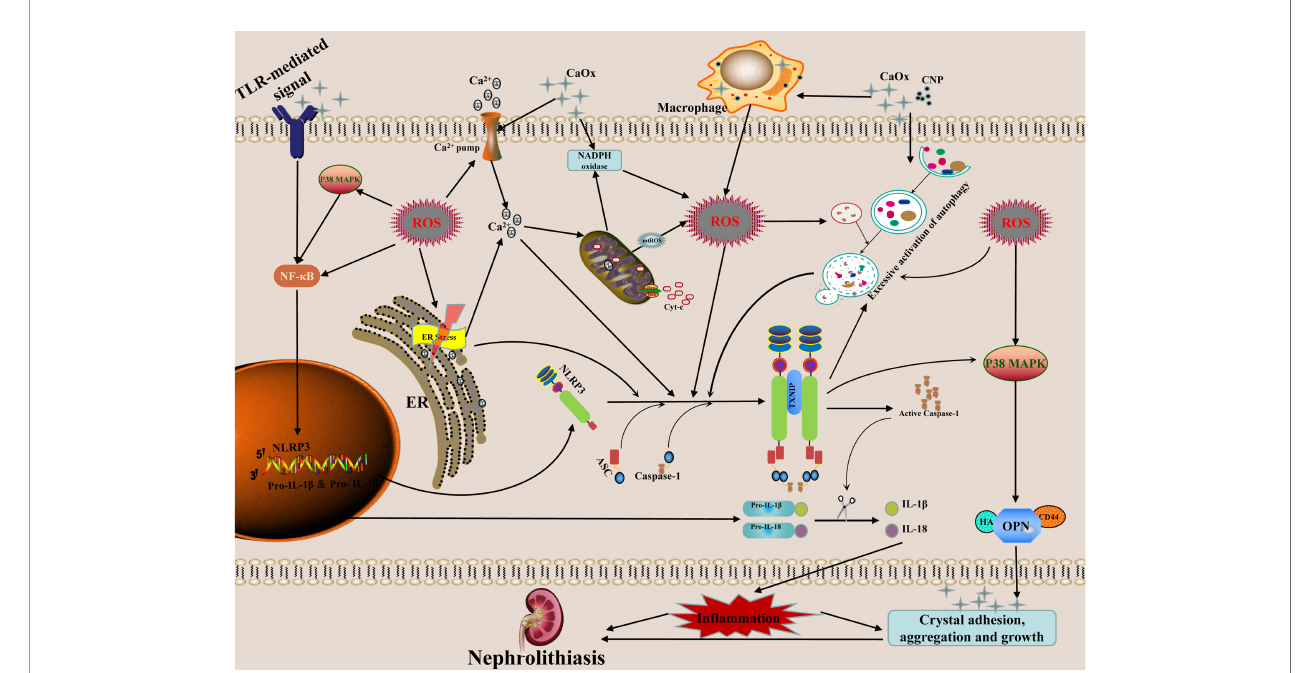
FIGURE 1 | Possible mechanism and regulation of ROS-induced NLRP3 in fl ammasome activation in the formation of calcium oxalate nephrolithiasis. The secretion of mature forms of IL-1 b and IL-18 is the result of NLRP3 in fl ammasome activation. These mediators have the properties of pro-in fl ammatory activation, which in turn promote the adhesion, aggregation and growth of crystals. The interaction of crystals or nanoparticles with cells can cause mitochondrial damage and increased NADPH oxidase activity, and then generate ROS, which mediates NLRP3 in fl ammasome transcription and activation through the ROS-dependent of NF- k B and autophagy signaling pathway. ER induces ROS production via NOX4 and ERO1 during stress. The release of Ca2+in the ER causes mitochondrial damage which further aggravates the release of ROS. High concentration of ROS can induce excessive activation of autophagy, thereby stimulate the in fl ammasomes to release a great number of in fl ammatory factors. The activation of NLRP3 in fl ammasome may further increase the level of autophagy, resulting in an in fl ammatory chain